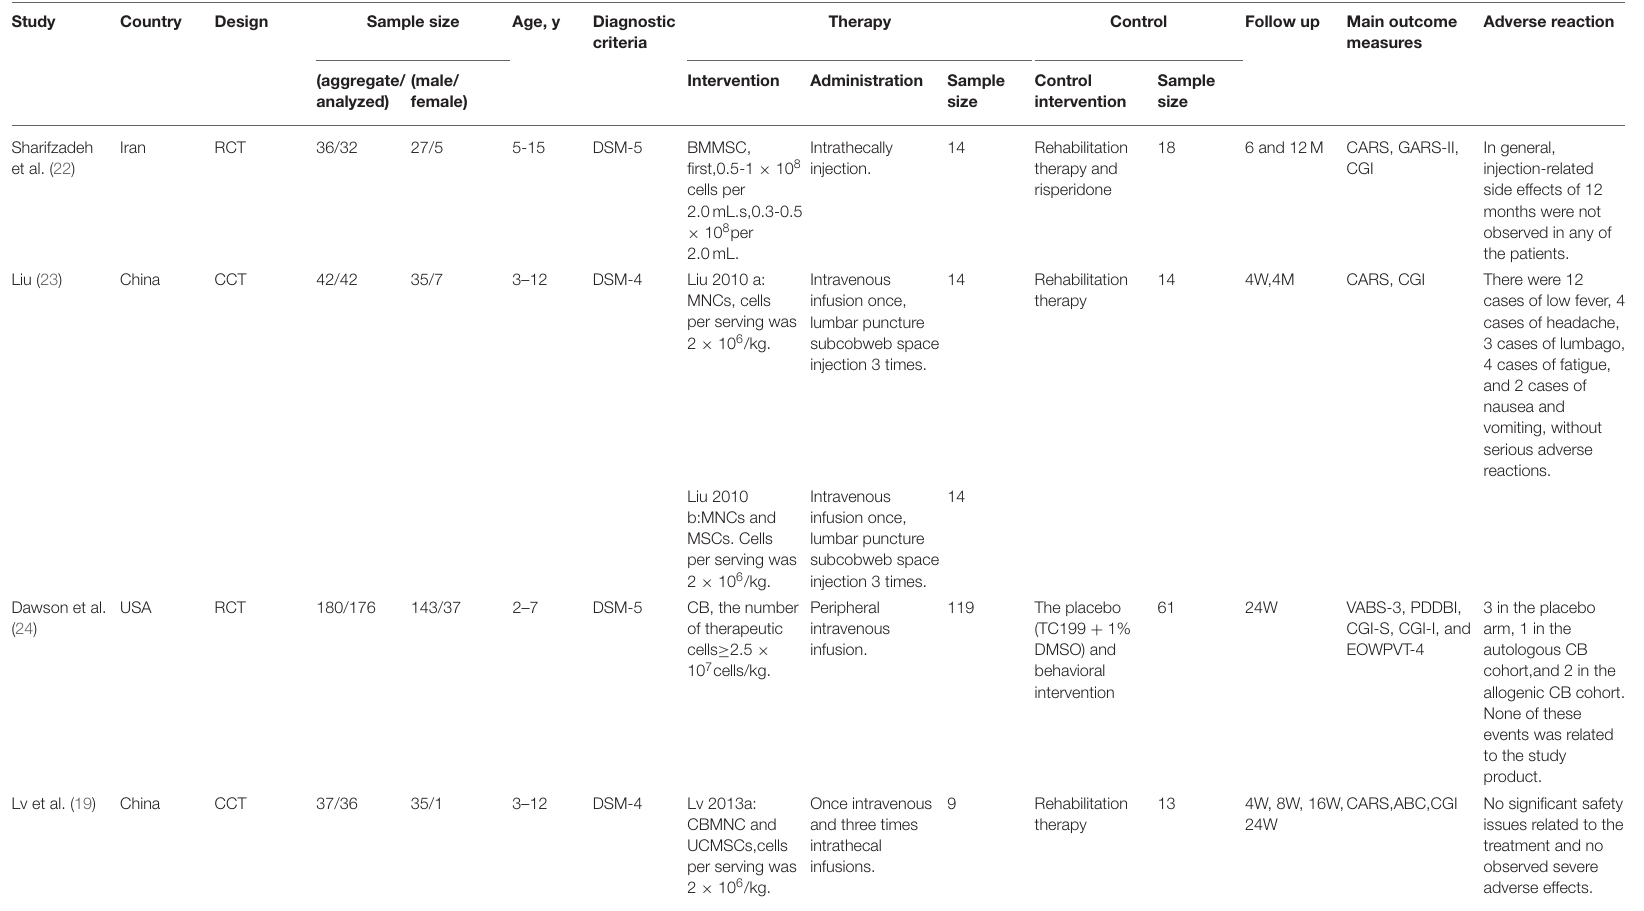
TABLE 1 | Summary of clinical studies of stem cells therapy for autism spectrum